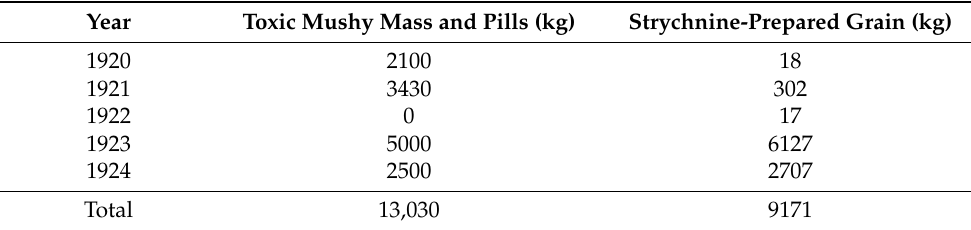
Table 1. Usage of rodenticides between 1920 and 1924 [27].